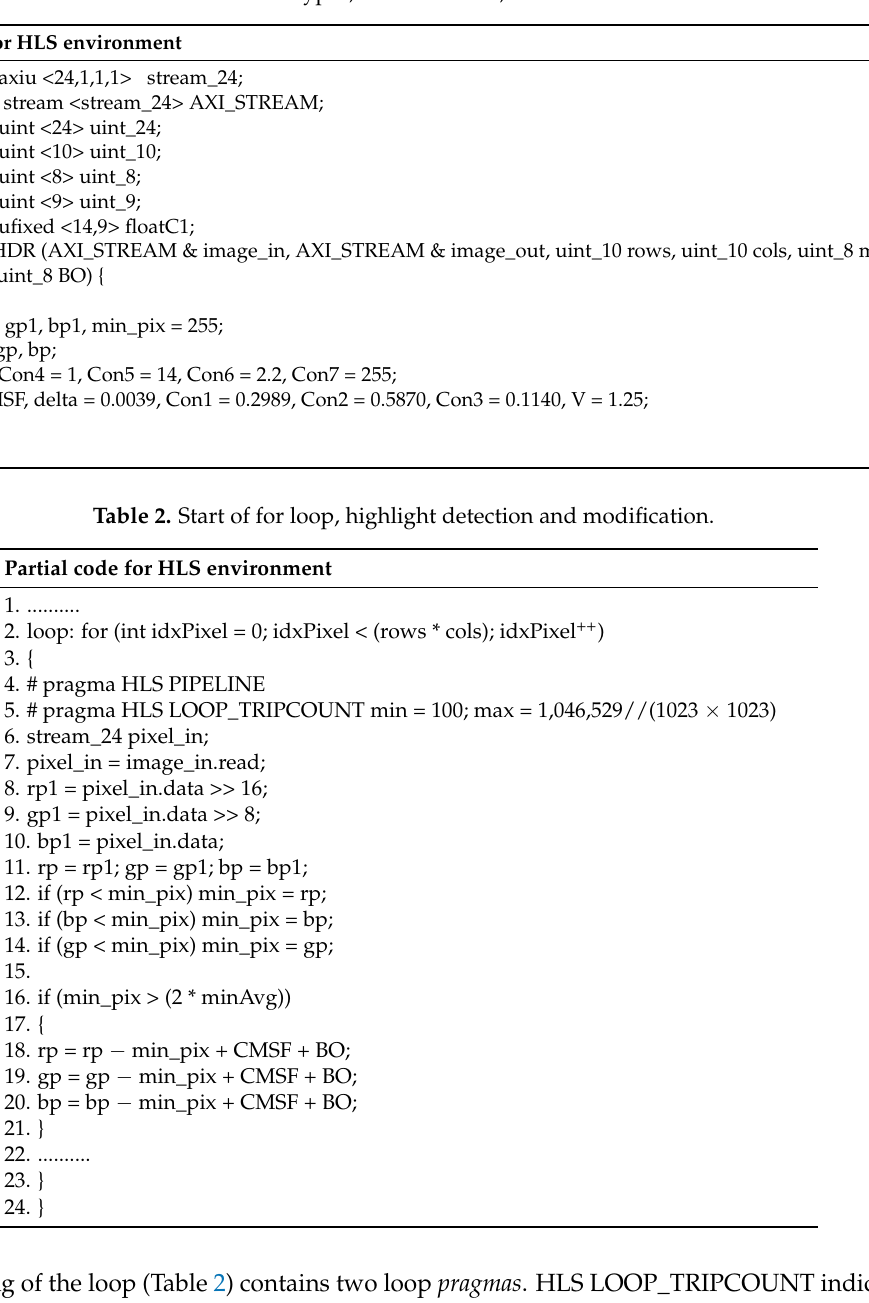
Table 1. Data types, main function, and variables.